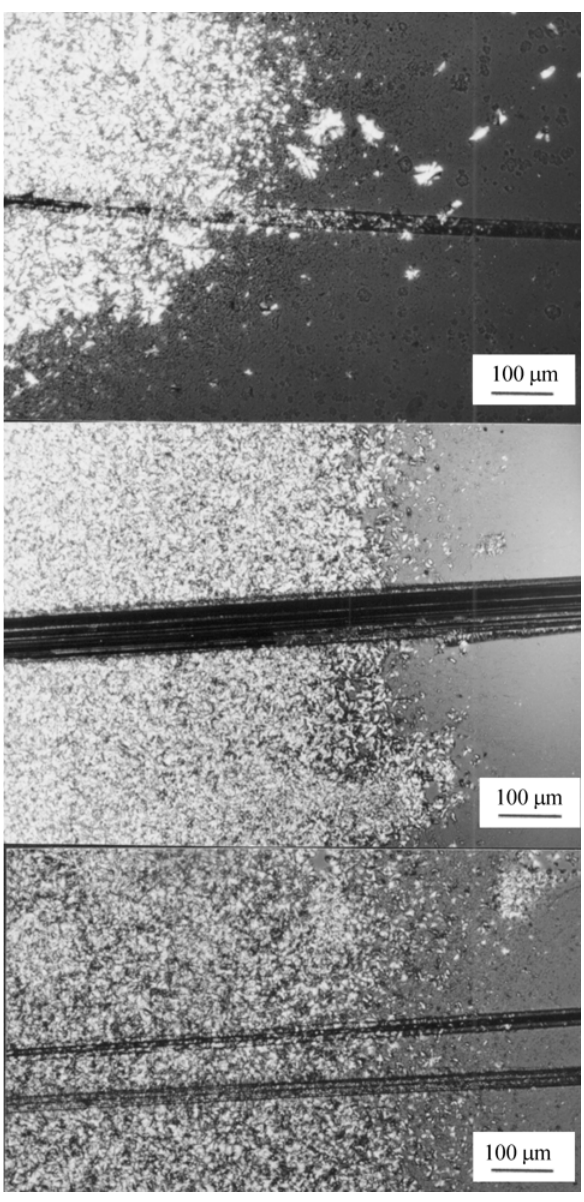
Figure 3. Crystallization front advancing along temperature gradient as viewed in situ under the hot stage optical microscope. Preferred nucleation on fiber surface in (a), transcrystallization along the fiber ahead of the homogeneous crystallization front in (b), only general homogeneous matrix crystallization in (c). Original magnification